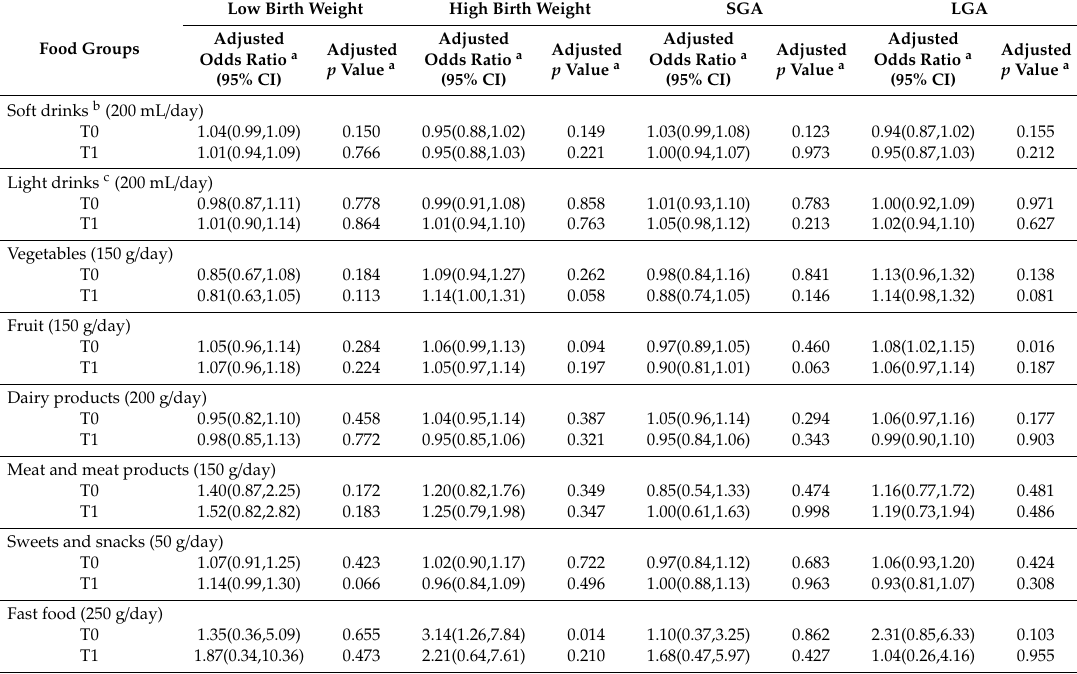
Table 3. Associations between maternal food intake and neonatal weight-related